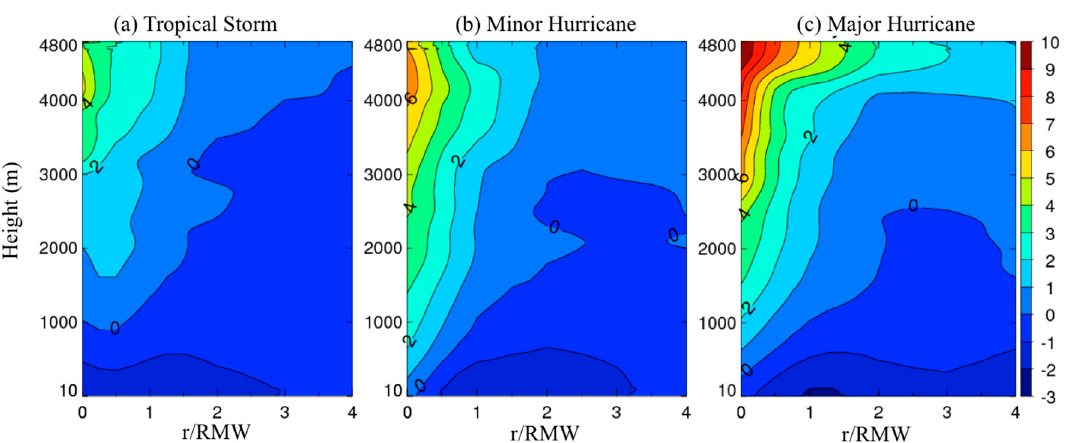
Figure 13. Composite analysis of the temperature anomaly (in K) as a function of altitude and normalized radius for ( a ) tropical storms, ( b ) minor hurricanes, and ( c ) major hurricanes. The contour interval is 1 K in all panels.